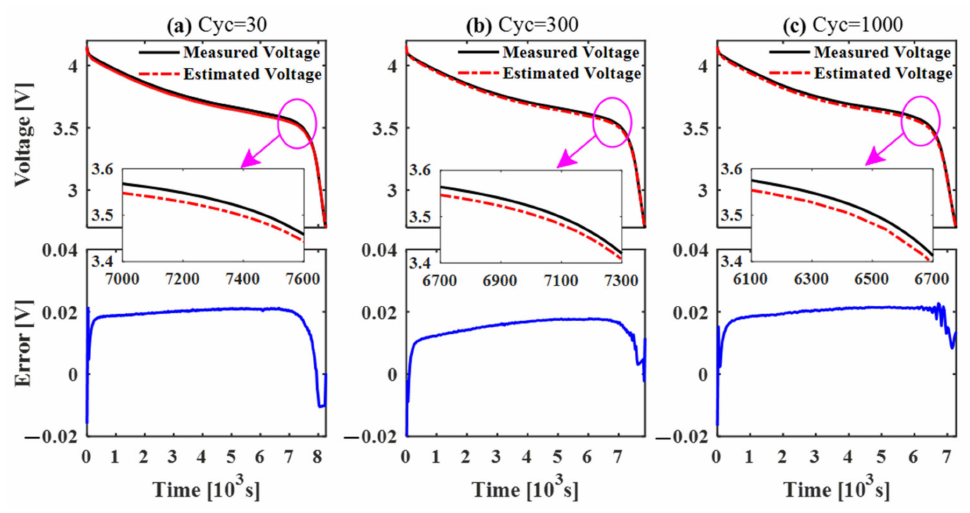
Figure 6. The validation results at ( a ) Cyc = 30, ( b ) Cyc = 300 and ( c ) Cyc = 1000 in the CCC test profile. In Figure 6, the black solid line indicates the measured TOV, while the red solid